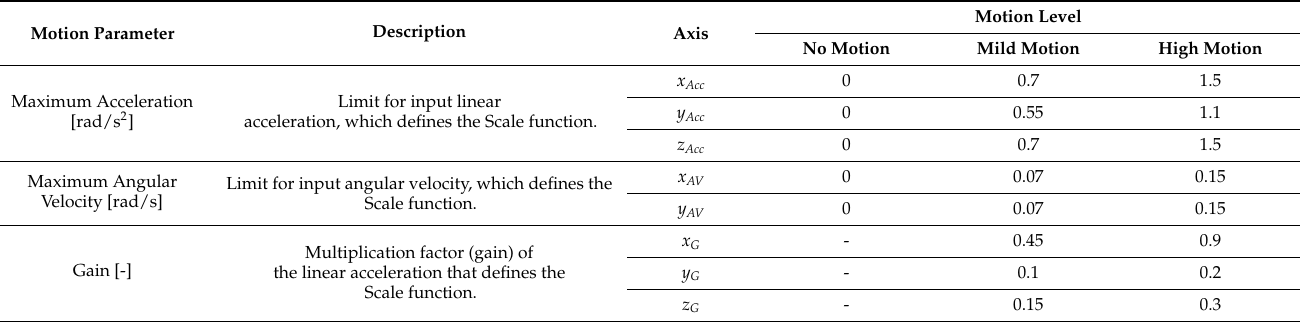
Figure 6. Representation of the scale function (defined by the parameters in Table 1) which scales the input signal from the mathematical model of the simulated vehicle to the motion platform. Table 2. Summary of the motion platform parameters that define scale function (Figure 6) tuned for different motion conditions, namely “No motion”, “Mild motion”, and “High motion” levels of motion cues.